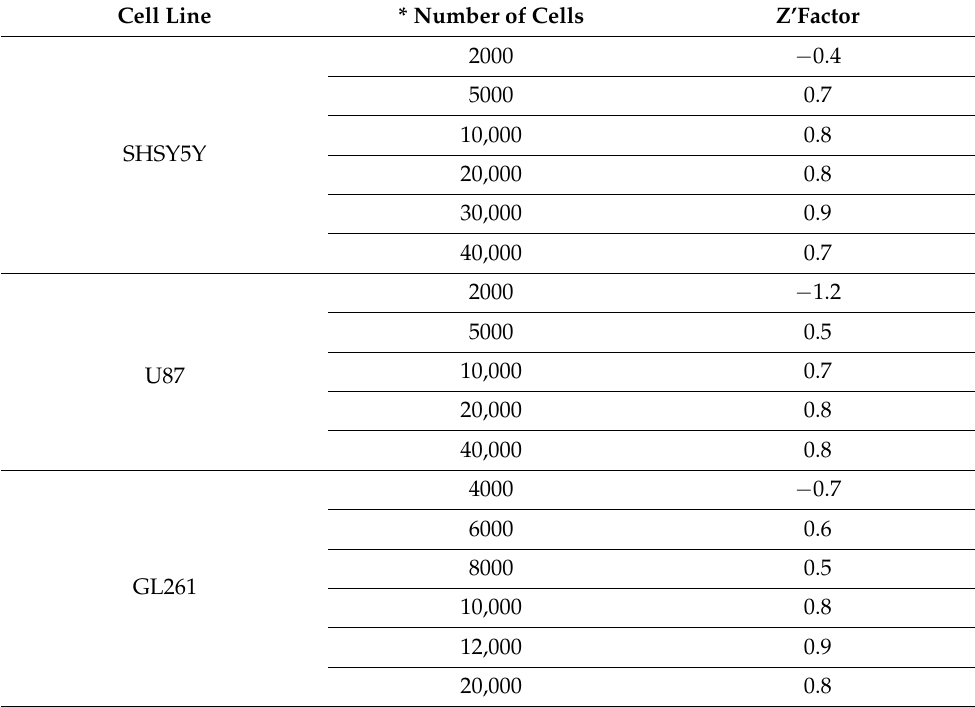
Table 3. Z’factor values for SHSY5Y, U87, and GL261 cell